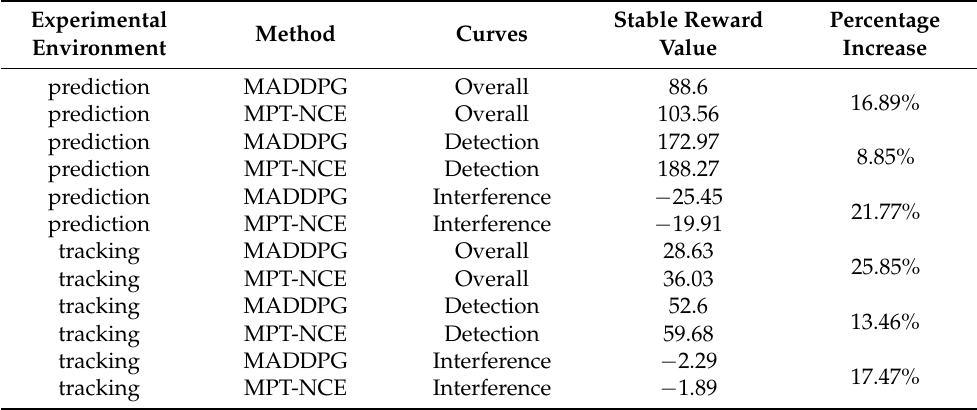
Figure 10. Tracking experimental performance comparison chart: ( a ) shows the comparison chart of training times and ( b ) shows the comparison chart of reward function values. Table 4. Comparison of stable reward values under different experimental environments.